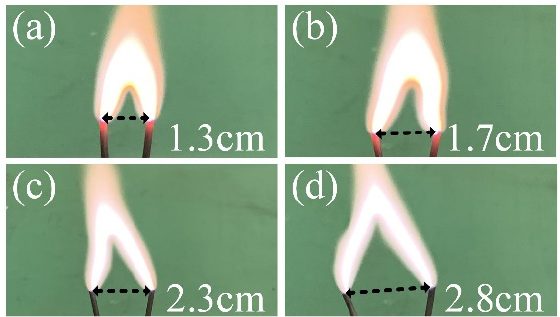
Figure 2. The photos of arc discharge with different gap distances.